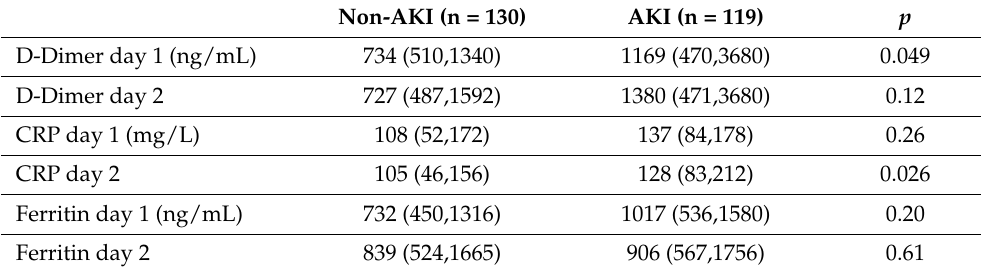
Table 3. Inflammatory and thrombotic markers in COVID-19 patients with and without AKI.